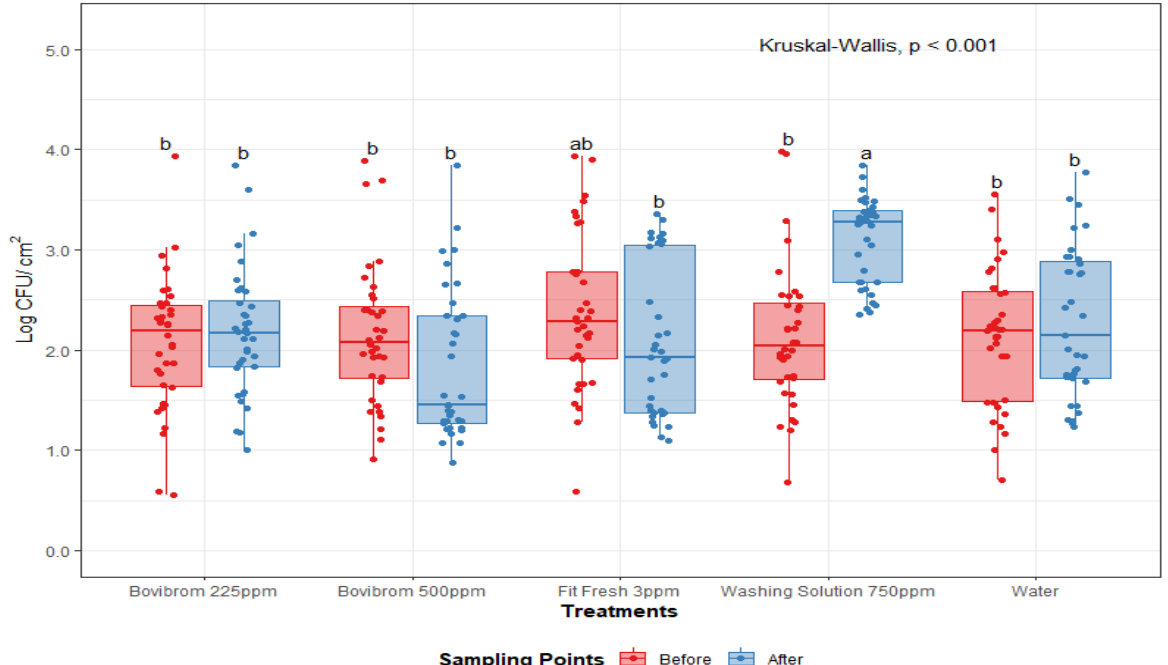
Figure 1. Mesophilic aerobic plate counts (Log CFU/cm 2 ) before and after treatment application on pork loin sections ( n = 36 per treatment). In each boxplot, the horizontal line crossing the box represents the median, the bottom and top of the box are the lower and upper quartiles, the vertical top line represents the upper interquartile range, and the vertical bottom line represents the lower interquartile range. Boxes with different letters a,b are significantly different according to Kruskal–Wallis analysis followed by pairwise comparison Wilcoxon’s test at p < 0.05. The points represent the actual data points. Active ingredients: Bovibrom = 1,3-Dibromo-5,5-dimenthylhydantoin; Fit Fresh = chlorine dioxide; Washing Solution = rhamnolipid.